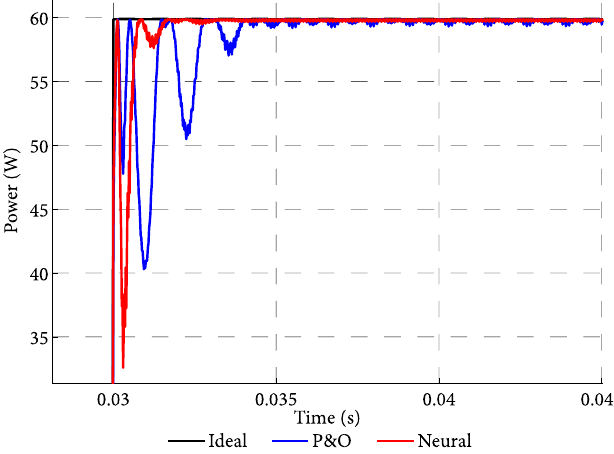
Figure 19. Output power of the PV module for an irradiation change from 100 to 1000 W/m 2 , 50